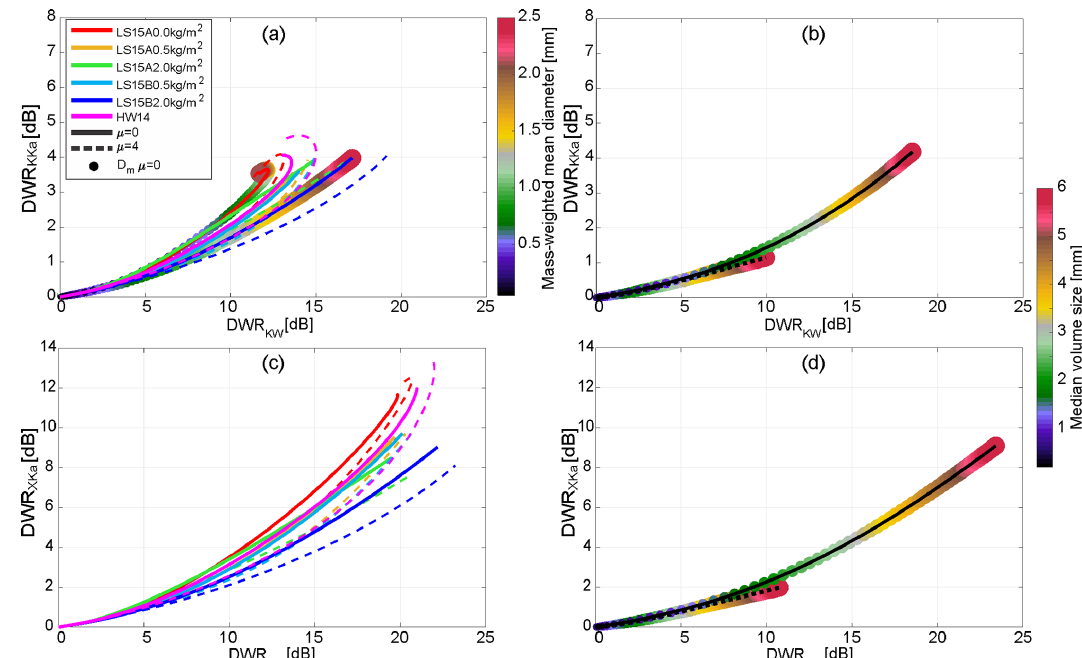
Figure 1. DWR of K-band (24GHz) reflectivity to Ka-band (35.5GHz) reflectivity versus that of K-band reflectivity to W-band (94GHz) reflectivity from (a) the self-similar Rayleigh–Gans approximation (SSRGA) scattering property database and (b) Matrosov et al. (2019), accounting for particle aspect ratio (AR). (c) and (d) are the same as (a) and (b) , respectively, but for the DWR of X-band (10.7GHz) reflectivity to Ka-band reflectivity versus that of X-band reflectivity to W-band reflectivity. Line colors in (a) and (c) represent particle models listed in Table A1. Solid and dashed lines in (a) and (c) represent the shape parameter ( µ ) of the PSD (particle size distribution) equal to 0 and 4, respectively. The color of circles in (a) represents the water-equivalent mass-weighted volume diameter ( D m ) of each PSD used to calculate DWRs; here, D m values for the particle models of unrimed aggregates with µ = 0 (solid red line) and aggregates with a high rime degree (solid blue line) of Leinonen and Szyrmer (2015) are presented. Solid and dashed lines in (b) and (d) represent AR = 0.8 and AR = 0.3, respectively. The DWRs in (b) and (d) were calculated for PSDs with µ = 0 and median volume particle size (color of circles) ranging from 0.2 to